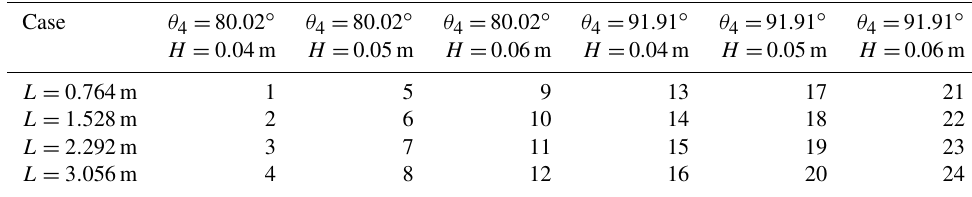
Table 1. Summary of basic parameters calculated in Tank